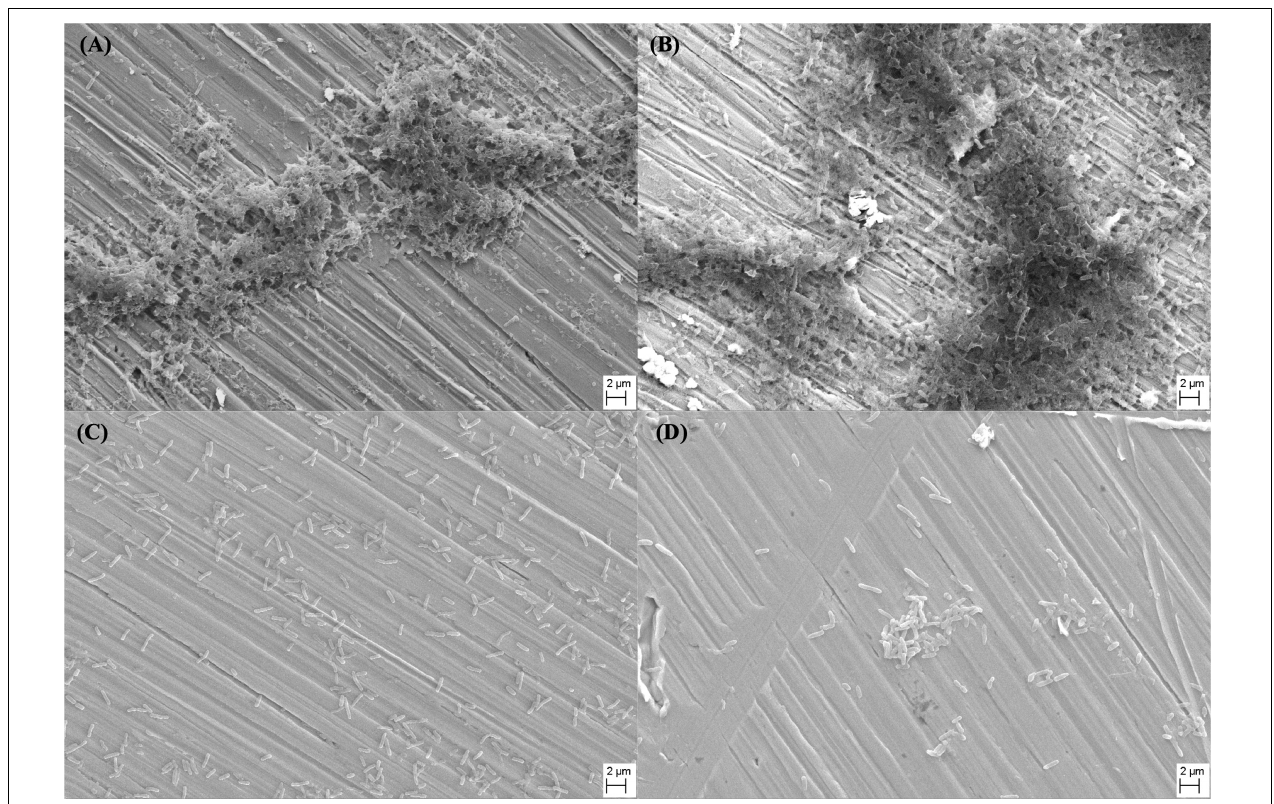
FIGURE 3 | SEM images of Pseudomonas aeruginosa biofilms that formed on the surfaces of (A) 304L BM, (B) 304L WZ, (C) 304L-Cu BM, and (D) 304L-Cu WZ specimens after 14 days of immersion test. BM, base metal; WZ, welding zone.